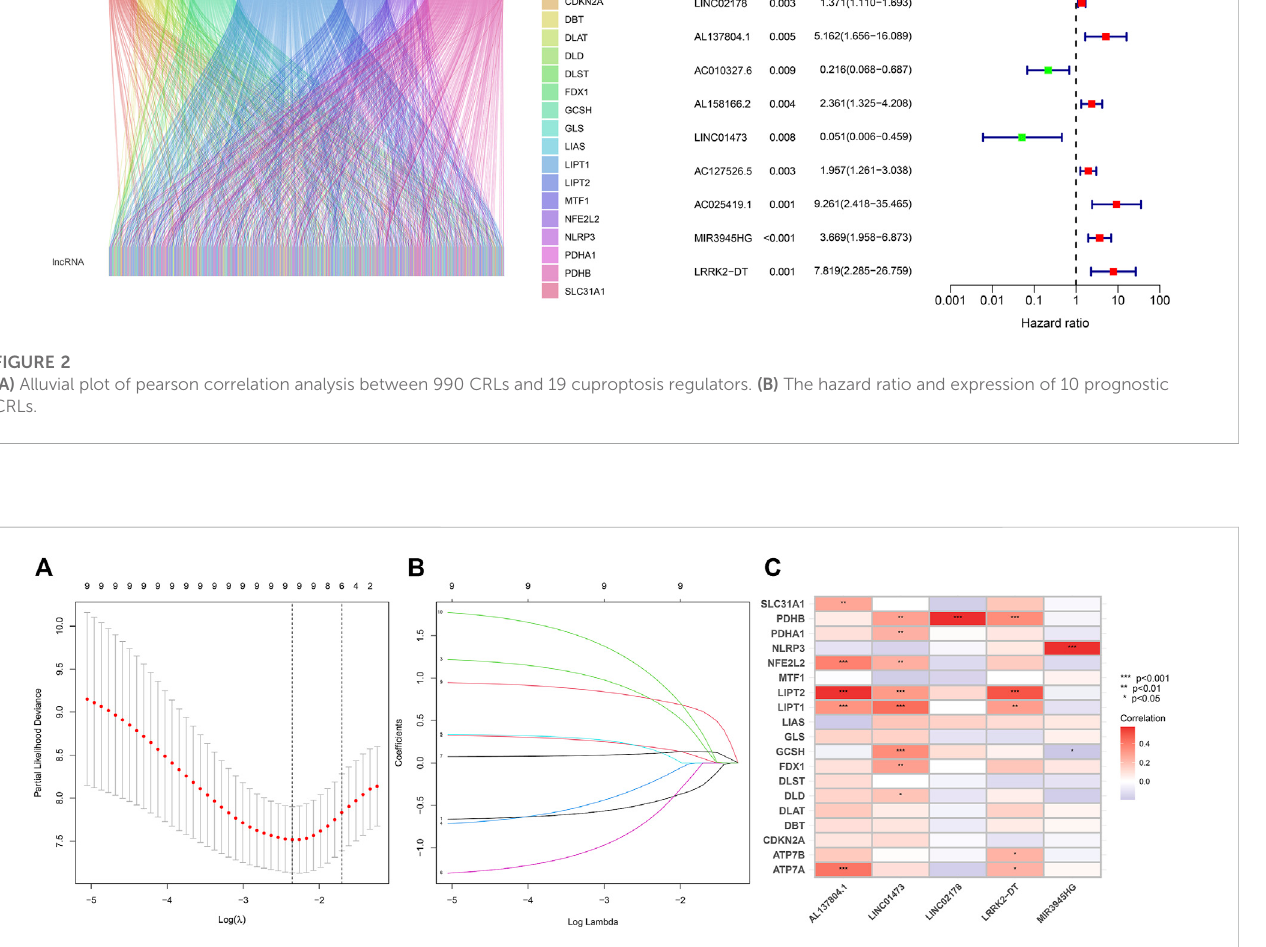
FIGURE 3 (A – B) LASSO Cox regression analysis between cuproptosis-related lncRNAs and HNSC patients. (C) Pearson correlation between 5 CRLs to build the prognostic model and 19 cuproptosis regulators. The asterisks indicated a statistically signi fi cant p -value (* p < 0.05; ** p < 0.01; *** p <